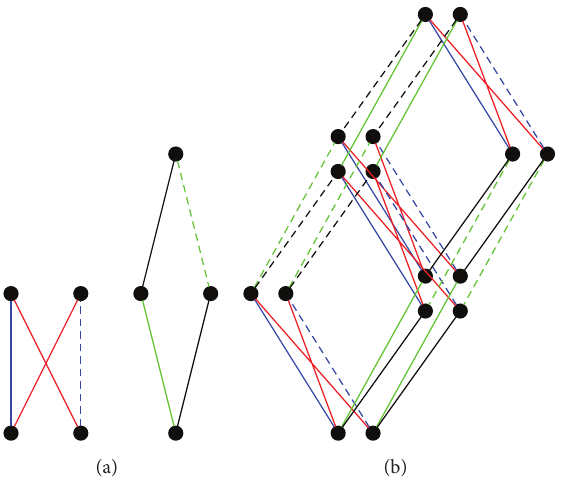
Figure 5: Constructing the 2 D Adinkra (b) from two smaller 1 D Adinkras (a) as a product. Note that the dashings are all “consistent” with the smaller Adinkras, except for the right-moving edges on the upper-left “boundary” of the rectangle; these correspond to right- moving edges where the grading corresponding to the first Adinkra has height 1